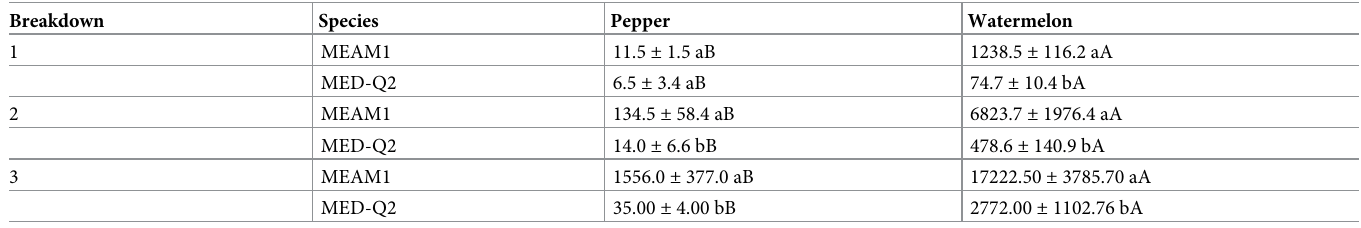
Table 1. Mean number of MEAM1 and MED-Q2 adults ± SE (males + females) from pepper and watermelon plants when inoculated with one species at 1 st , 2 nd and 3 rd breakdown intervals.